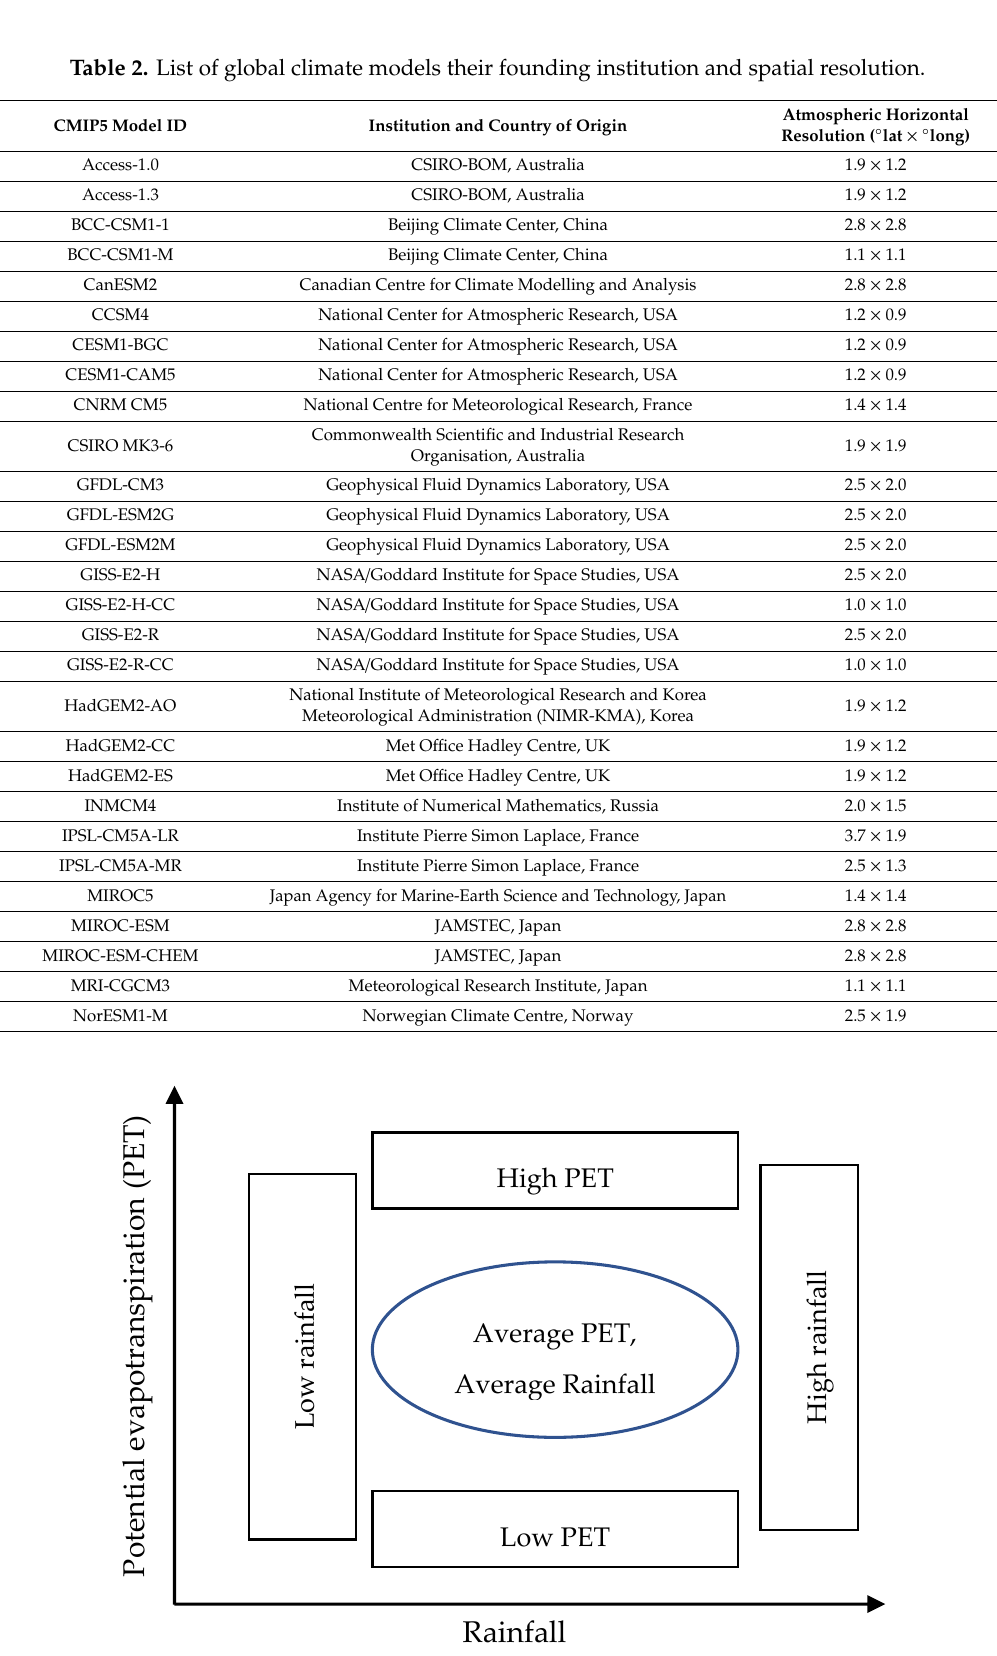
Figure 5. Method of selecting best GCMs for five scenarios (S1 to S5). Green, blue and orange dots represent 28 GCMs, five selected GCMs for S1 to S5 and average of 28 GCMs respectively. The error bar shows the spatial variability between six grids. In this study, rainfall and PET are projected based on scaling factors derived from GCM results. Historical data for the period of 1985 to 2015 were used as the baseline condition. Scaling factors and subsequent rainfall and PET time series were derived for a period over 2046–2075 for the RCP4.5 and RCP8.5 emission scenarios. Spatial variability between the meteorological stations and temporal variability at monthly, seasonal and annual timescale were investigated. A single set of scaling factors were used for all 16 districts in the study area, to reduce uncertainty in local variations. Three sets of time series data for rainfall and PET were constructed based on monthly, seasonal and annual scaling factors. Four seasons, each representing 3 calendar months (DJF, MAM, JJA and SON) were 0.96 0.981.001.021.041.061.081.10 0.90